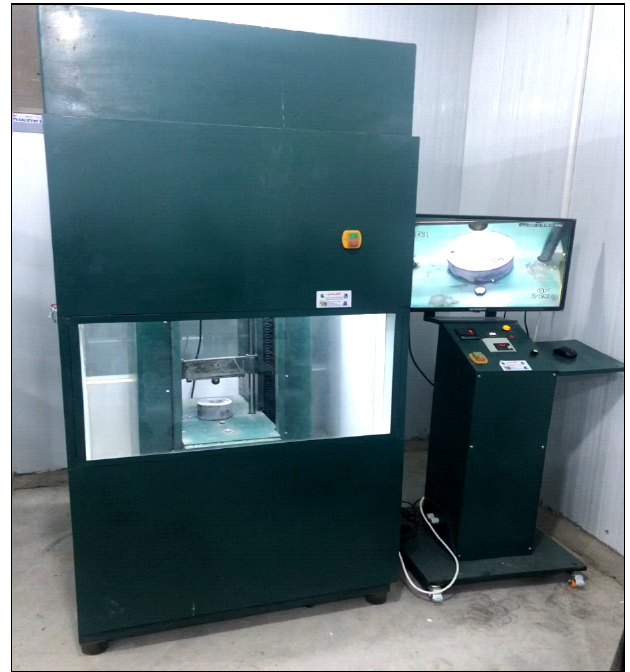
Figure 3. The automatic repeated impact testing machine.